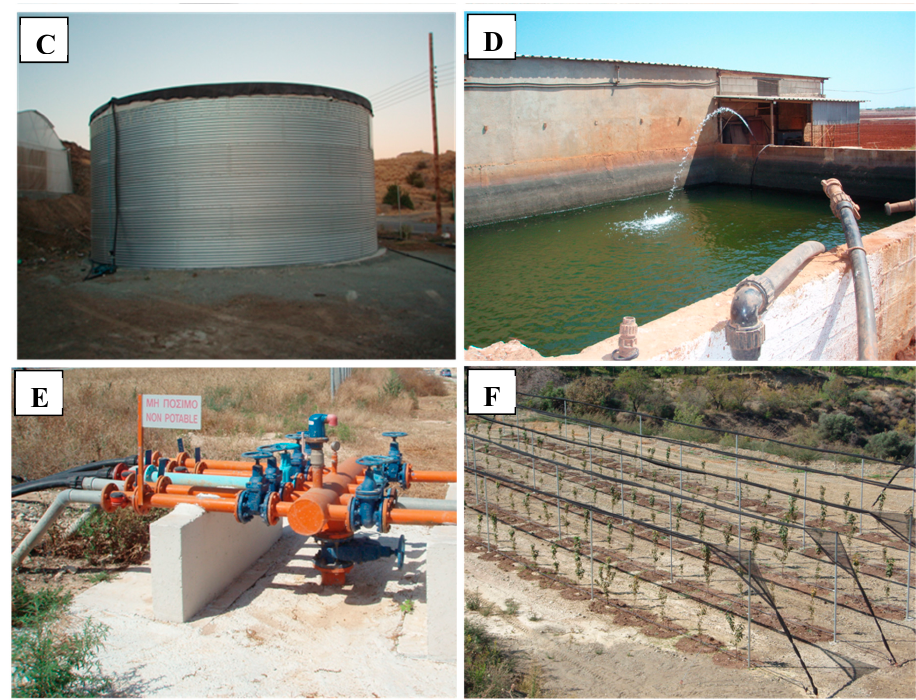
Figure 7. Rain water harvesting and storage in open reservoir ( A ); water storage in a covered reservoir minimizing water evaporation losses and algae growth ( B ); a commercial closed water reservoir ( C ); blended water from different sources ( D ); a water supply main manifold of recycle water ( E ); localized irrigation and net protection in a tree cropping system ( F ).